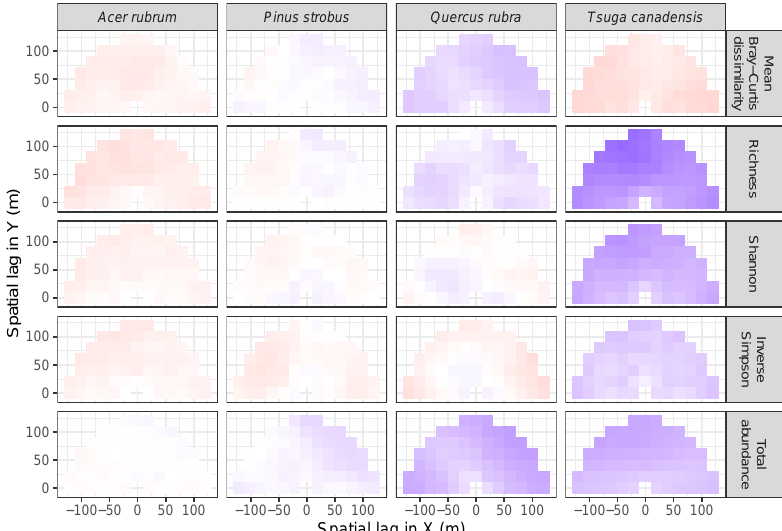
Figure 8. Codispersion between measures of diversity and total basal area of the four focal species in 20 20-m subplots in the 35-ha Harvard Forest plot. Codispersion coefficients were calculated for × spatial lags ranging from 0–125 m at 20-m intervals. The value of the codispersion coefficient can range from 1 (dark blue) through 0 (white) to 1 (dark red). Statistical significance of each codispersion − coefficient is shown in Figure 10. Summaries of codispersion values are given in Table A1).